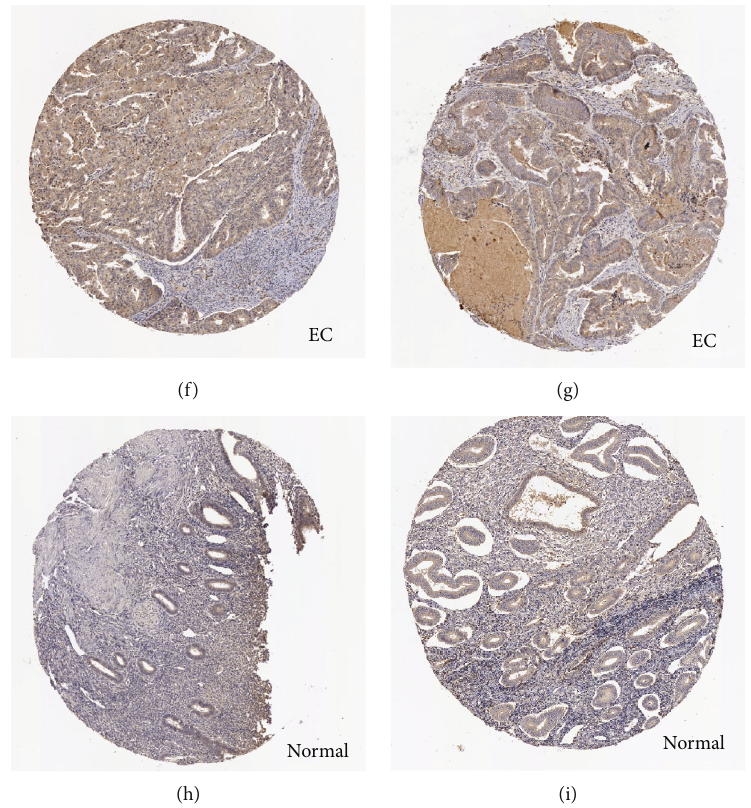
Figure 1: BCHE expression analysis. (a) BCHE expression in normal and tumor tissues in TCGA and GTEx pan-cancer data. (b) BCHE expression in unpaired EC samples. (c) BCHE expression in paired EC samples. (d) BCHE expression in GSE63678. (e) BCHE expression in GSE17025. (f, g) Representative images of immunohistochemistry showing BCHE expression in endometrial carcinoma tissues. (h, i) Representative images of immunohistochemistry showing BCHE expression in normal endometrial